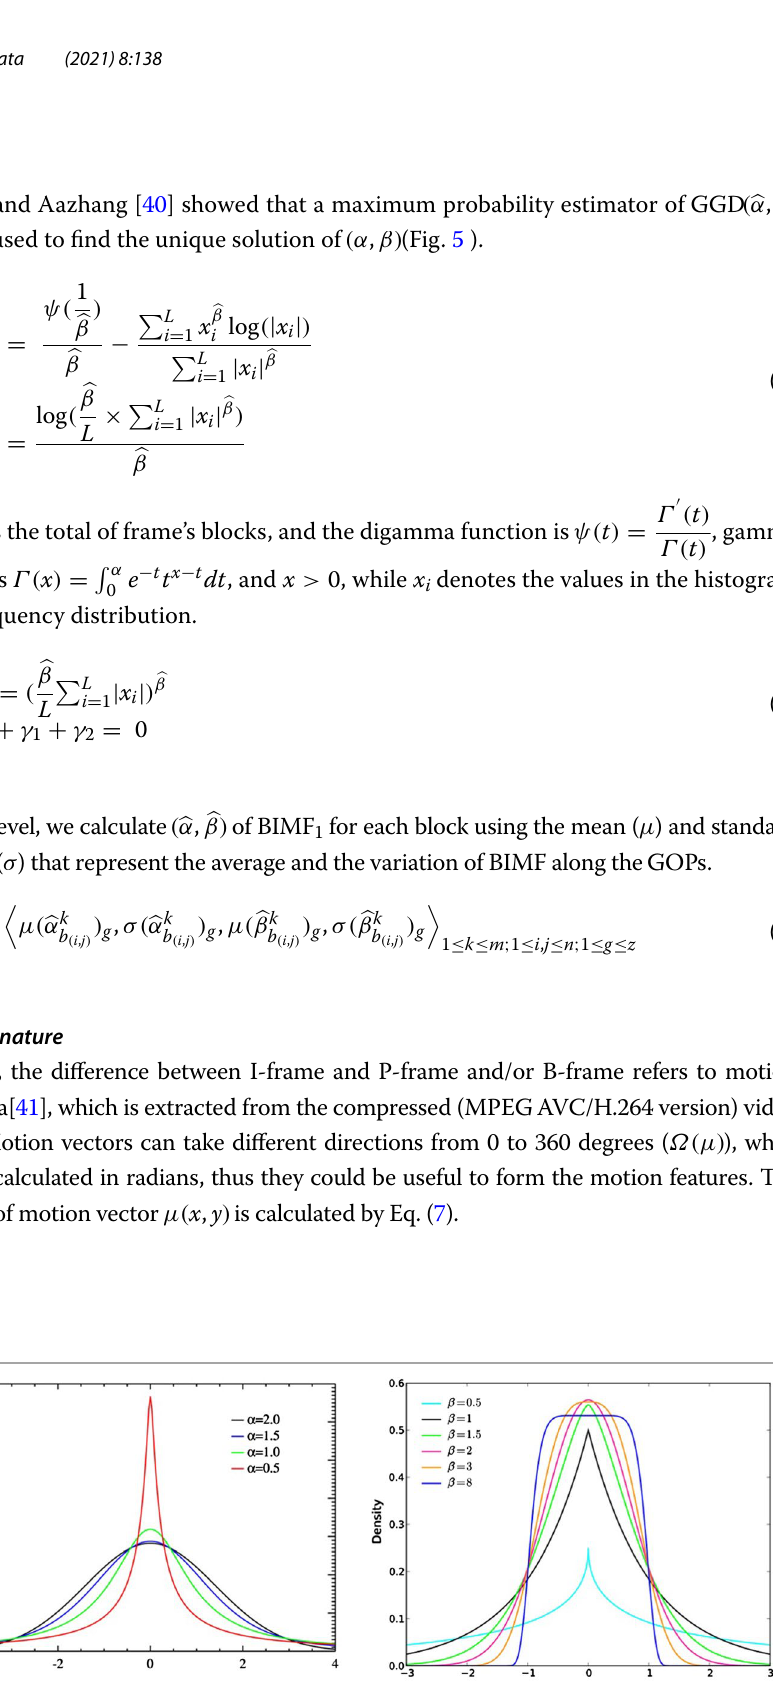
Fig. 5 Density of Generalized Gaussian Distribution ( a various values for α / β 1) (Wikimedia distribution